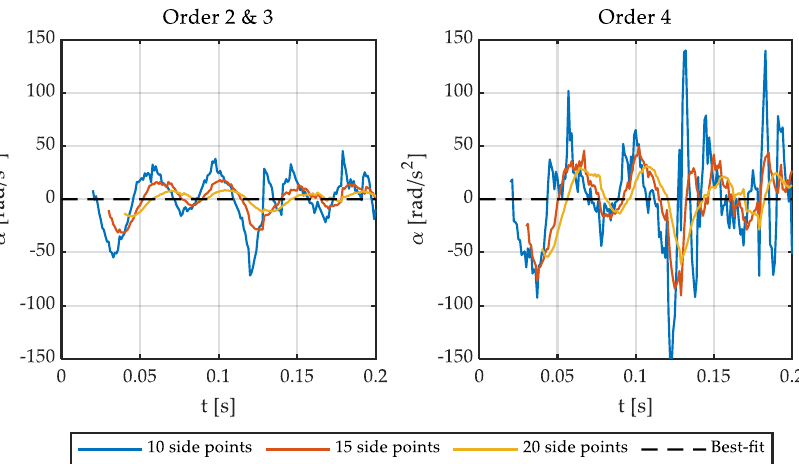
Figure 4. Angular acceleration fitted to polynomials of order 2, 3, and 4 with 10, 15, and 20 side points.